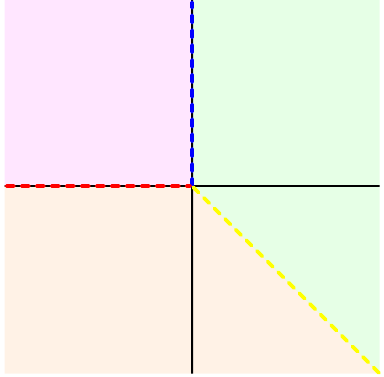
Figure 2 . Fan associated to the tropicalised Pl(cid:127)ucker variable w 25 of f Tr + (2 ; 5). The rays are depicted as dashed lines in blue, red and yellow, respectively. The cones are depicted in the composite color of the two rays by which they are